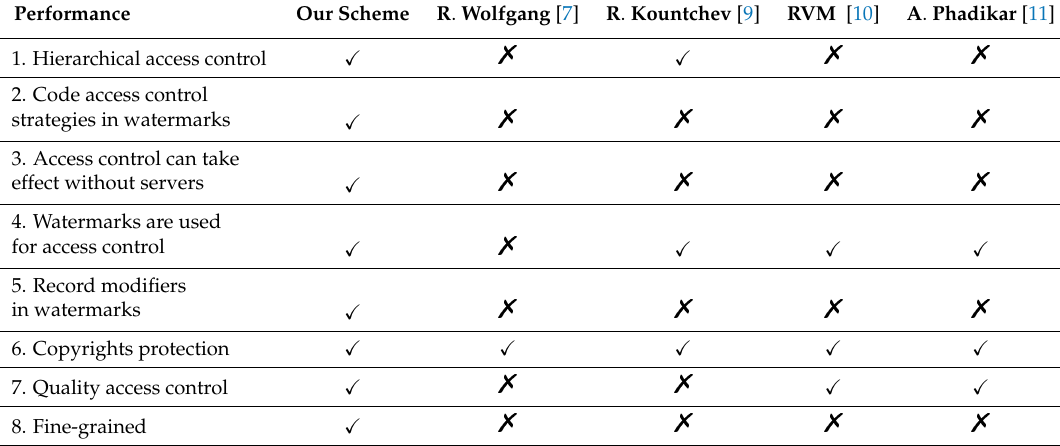
Table 1. The comparisons between Proposed Scheme and other existing related